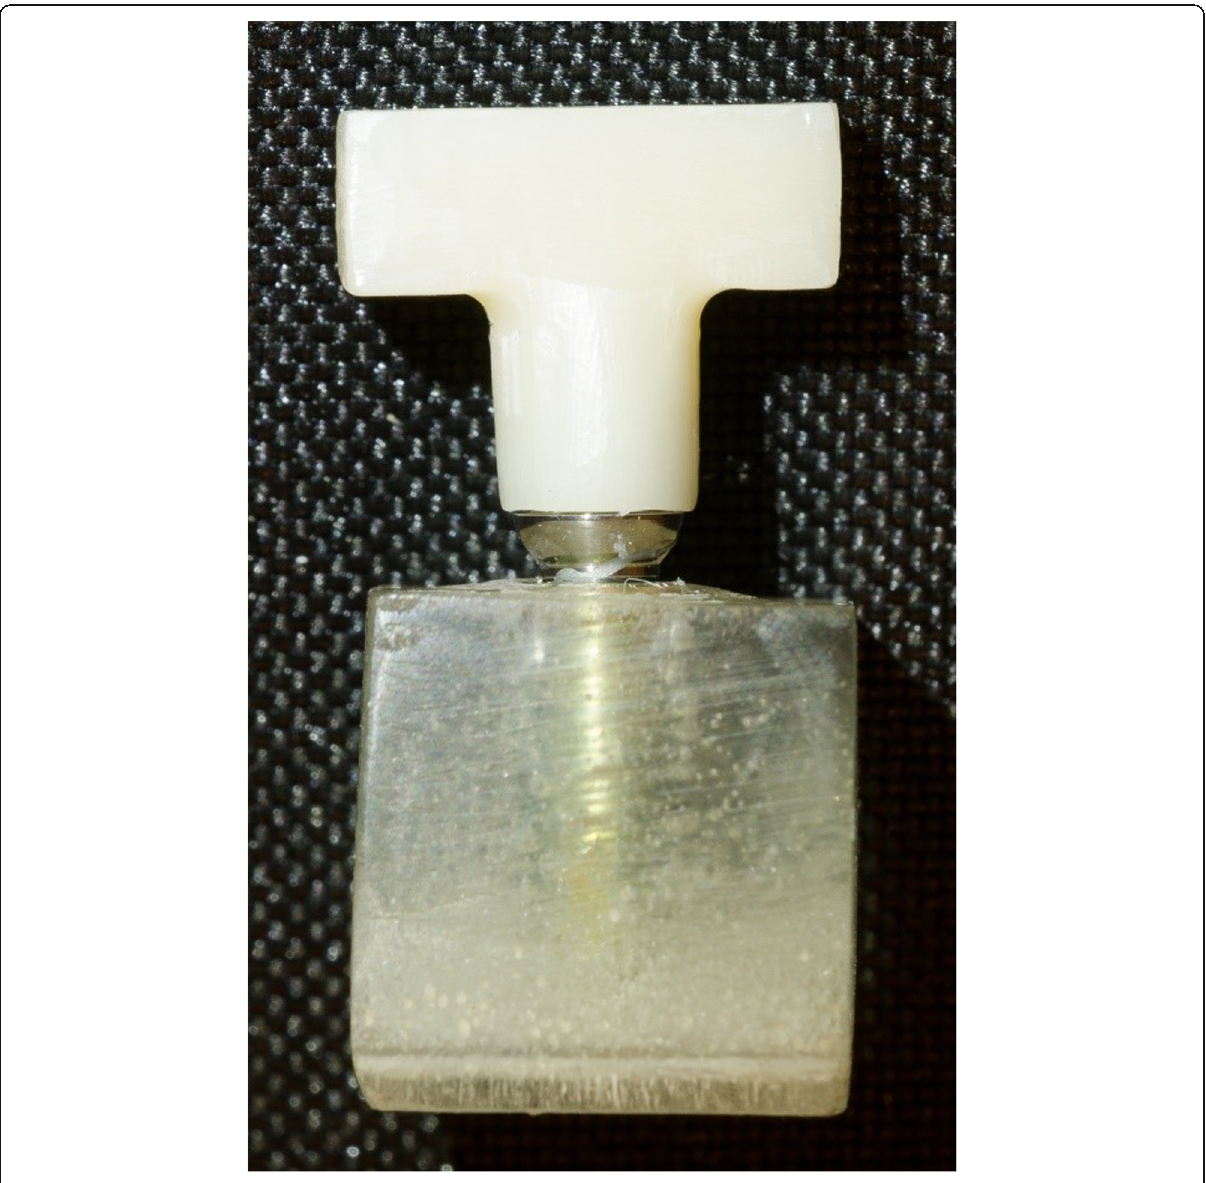
Fig. 3 Embedded implant with cemented